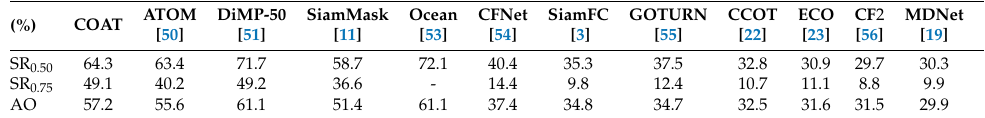
Figure 4. Success and precision plots for LaSOT test set. Best viewed on high-resolution display. Table 2. Quantitative comparison on the GOT-10k test